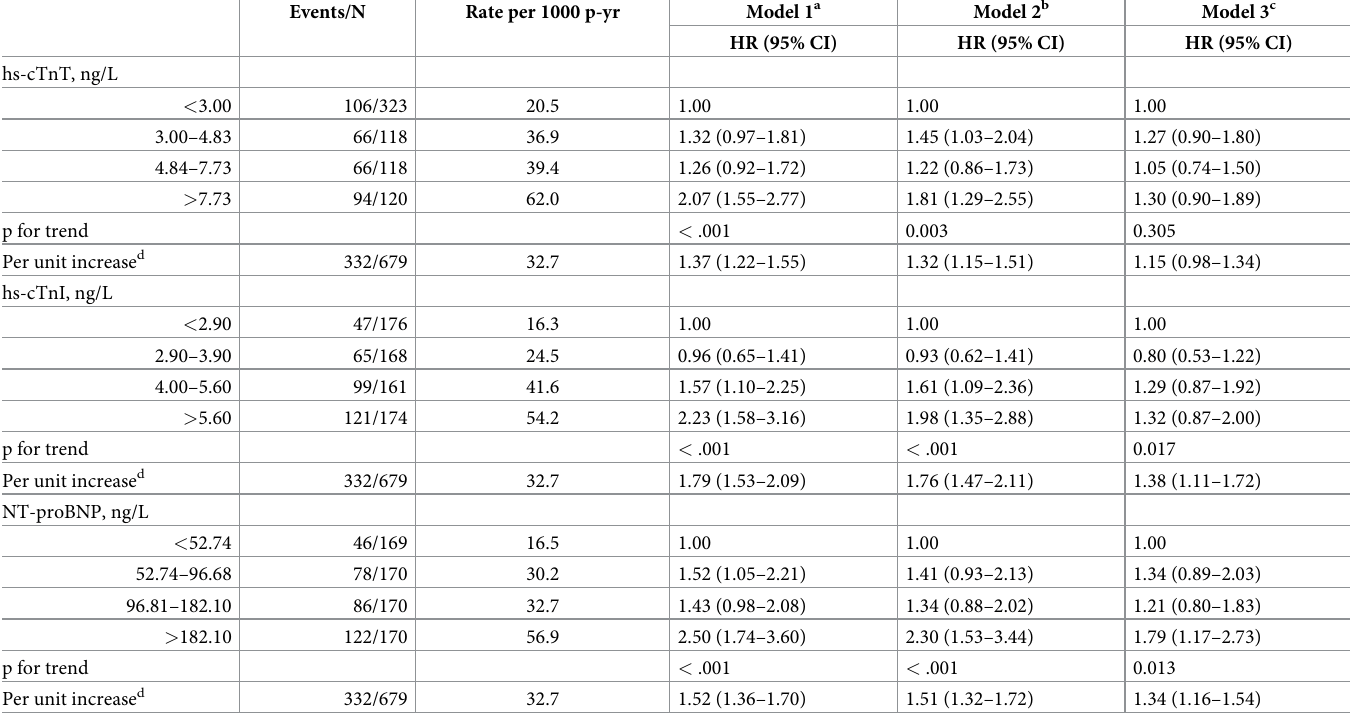
Table 3. Cox proportional regression analysis for